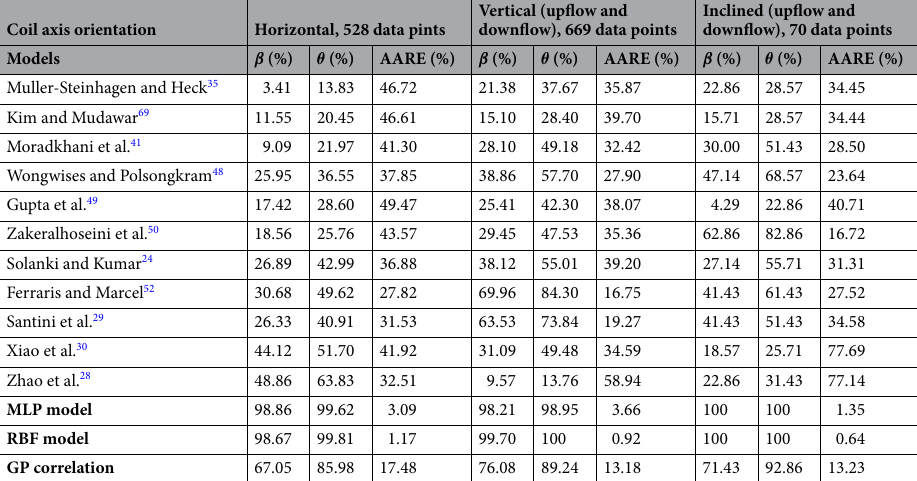
Table 7. Statistical errors of different models for estimating the two-phase FPD in coiled tubes at different orientations.